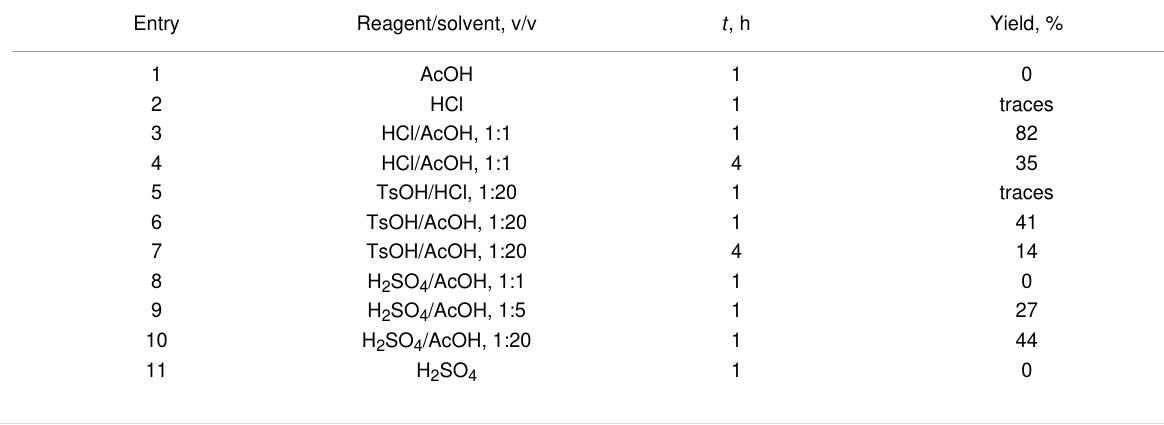
Table 3: Optimization of the reaction conditions towards pyrrolo[3,4- b ]pyridin-5-one derivative 1a from 7a